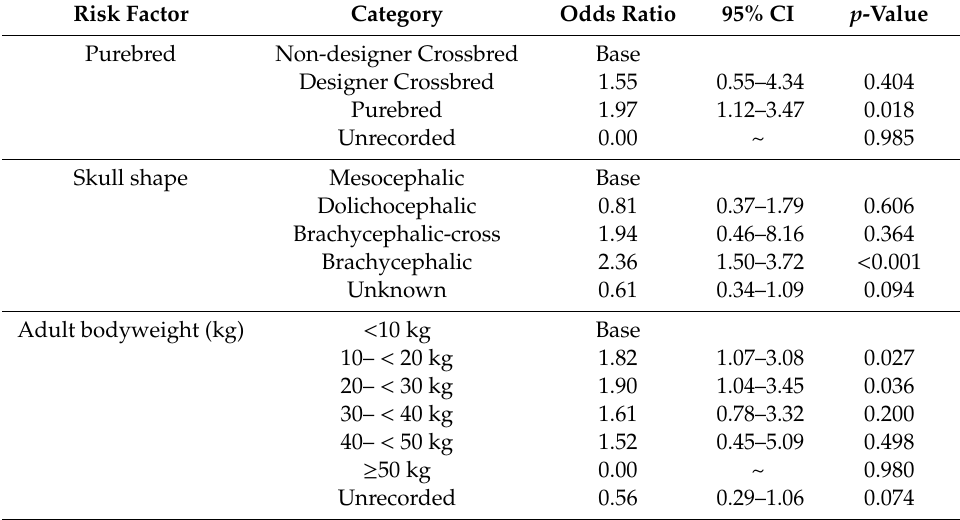
Table A3. Results for variables that individually replaced the breed type variable in the final multivariable logistic regression model (with age and sex / neuter) to evaluate risk factors associated with environmental heat related illness in dogs under primary veterinary care in the VetCompass Programme.